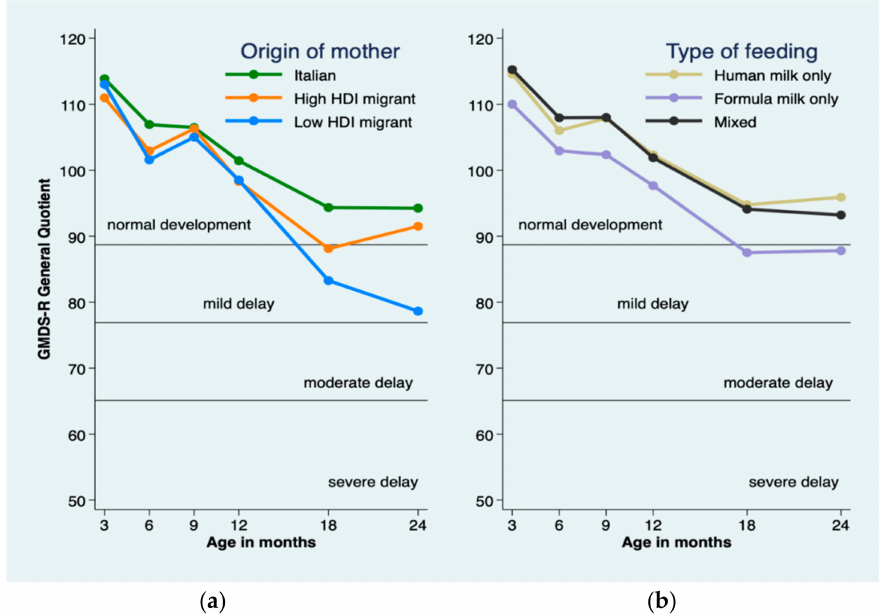
Figure 2. Observed trajectories of revised Gri ffi ths Mental Development Scales (GMDS-R) general quotient by origin of mother ( a ) and by type of feeding ( b ). HDI, Human Development